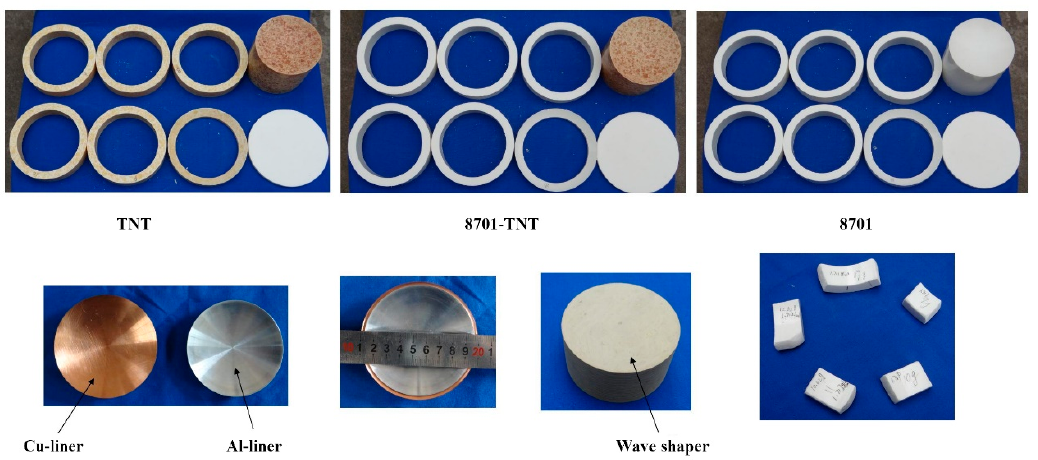
Figure 6. Compositions of three shaped charges: OSC (TNT), DLSC (8701-TNT) and OSC (8701).